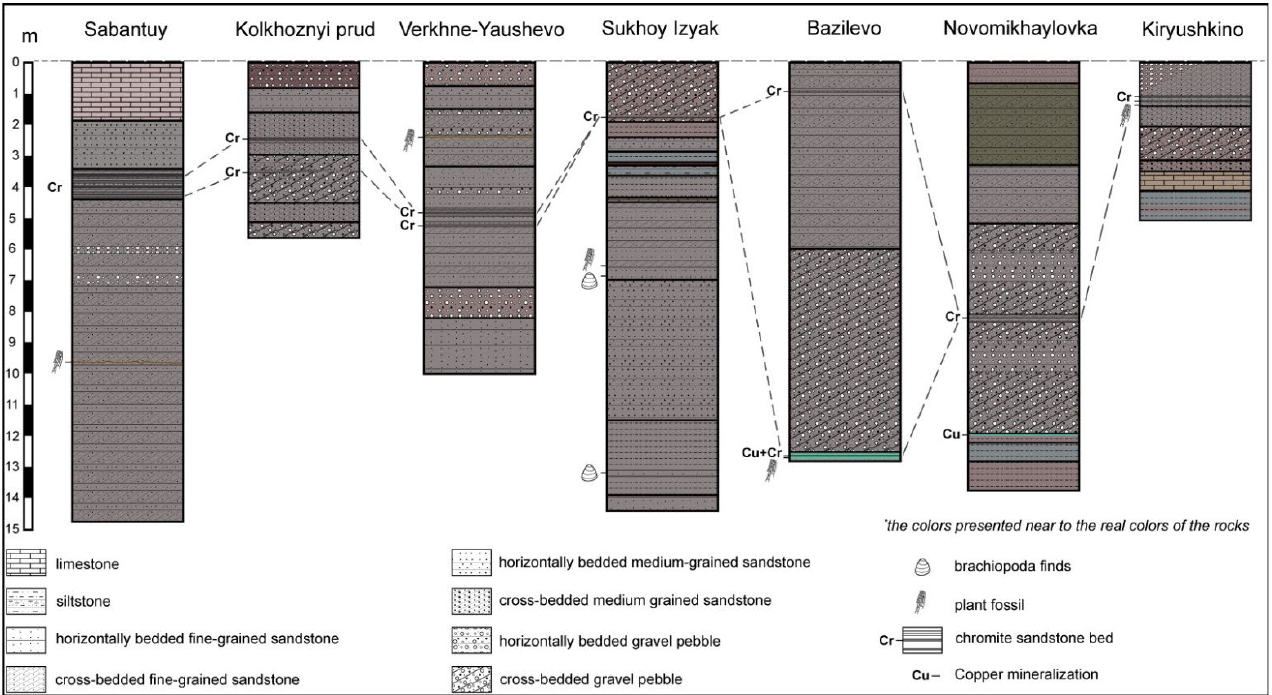
Figure 3. Lithology of the studied chromite-bearing deposits in the Southern Pre-Urals. The sandstone hosting the chromite-rich bed is typically well-sorted and contain well-rounded clasts. The cement of the sandstone is pore-filling carbonate (mainly calcite). The size of particles is 0.3–0.4 mm. Sand particles occur as lithic fragments (77%–82%), quartz (9%–12%), silicate (6%–10%) and ore minerals (1%). The sandstones underlying the ore bed also contain porous-type carbonate cement, but they show a smaller size of particles (0.2 mm), less-rounded and irregularly (well- to medium-) sorted clasts. The sandstones overlying the chromite-rich bed also contain irregularly sorted and rounded clasts, the size of their particles is 0.3–0.4 mm. The studied sandstones fall in the field of litharenites on the ternary QRF diagram (Figure 4a) and in the field of phyllarenites on the SRF-VRF-MRF diagram (Figure 4b). More than a half of the rock clasts are metamorphic (crystalline schists, quartzites, serpentinites) and fewer for sedimentary (siltstones, argillaceous schists) rocks, while detrital magmatic rocks are not more than 3%. The sandstones under- and overlying the chromite-rich bed are compositionally similar to the sandstones interlayering with chromite sandstones. The latter contain a little bit more fragments of magmatic rocks and silicate minerals (plagioclase, amphibole, clinopyroxene). Magmatic rocks are represented by basalts and andesibasalts with a pilotaxitic and an intersertal texture.